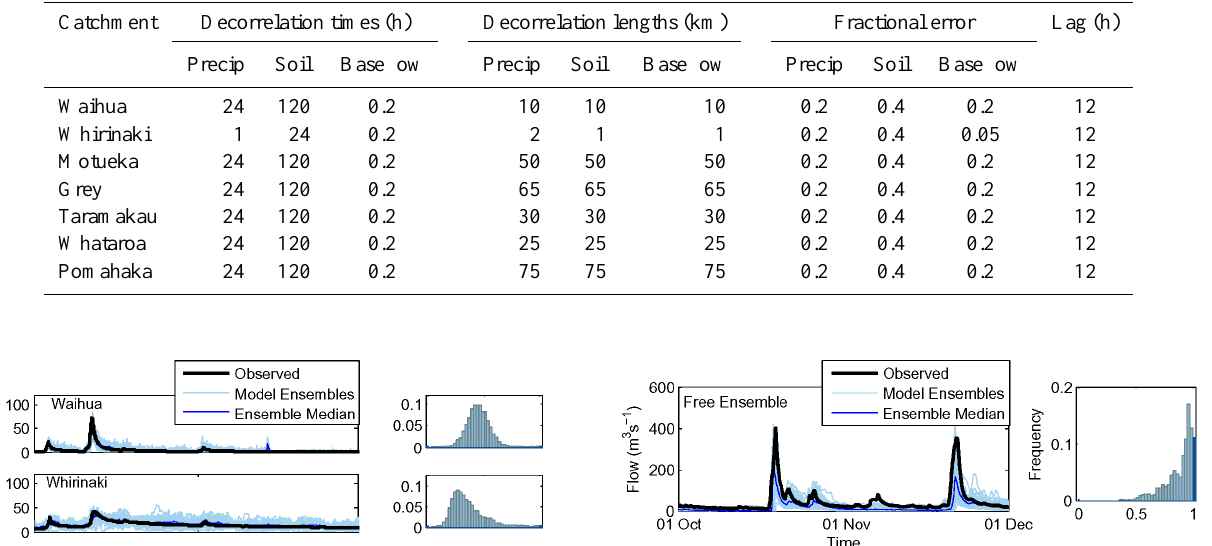
Table 2. REnKF model parameters used for each catchment.